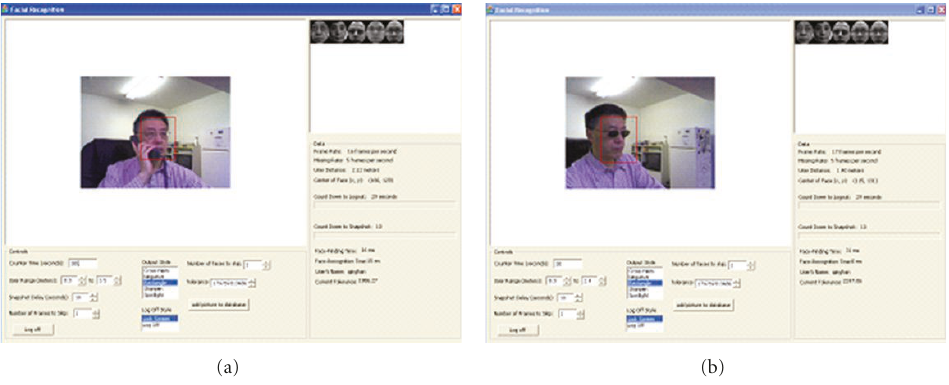
Figure 3: Recognize partially occluded faces.